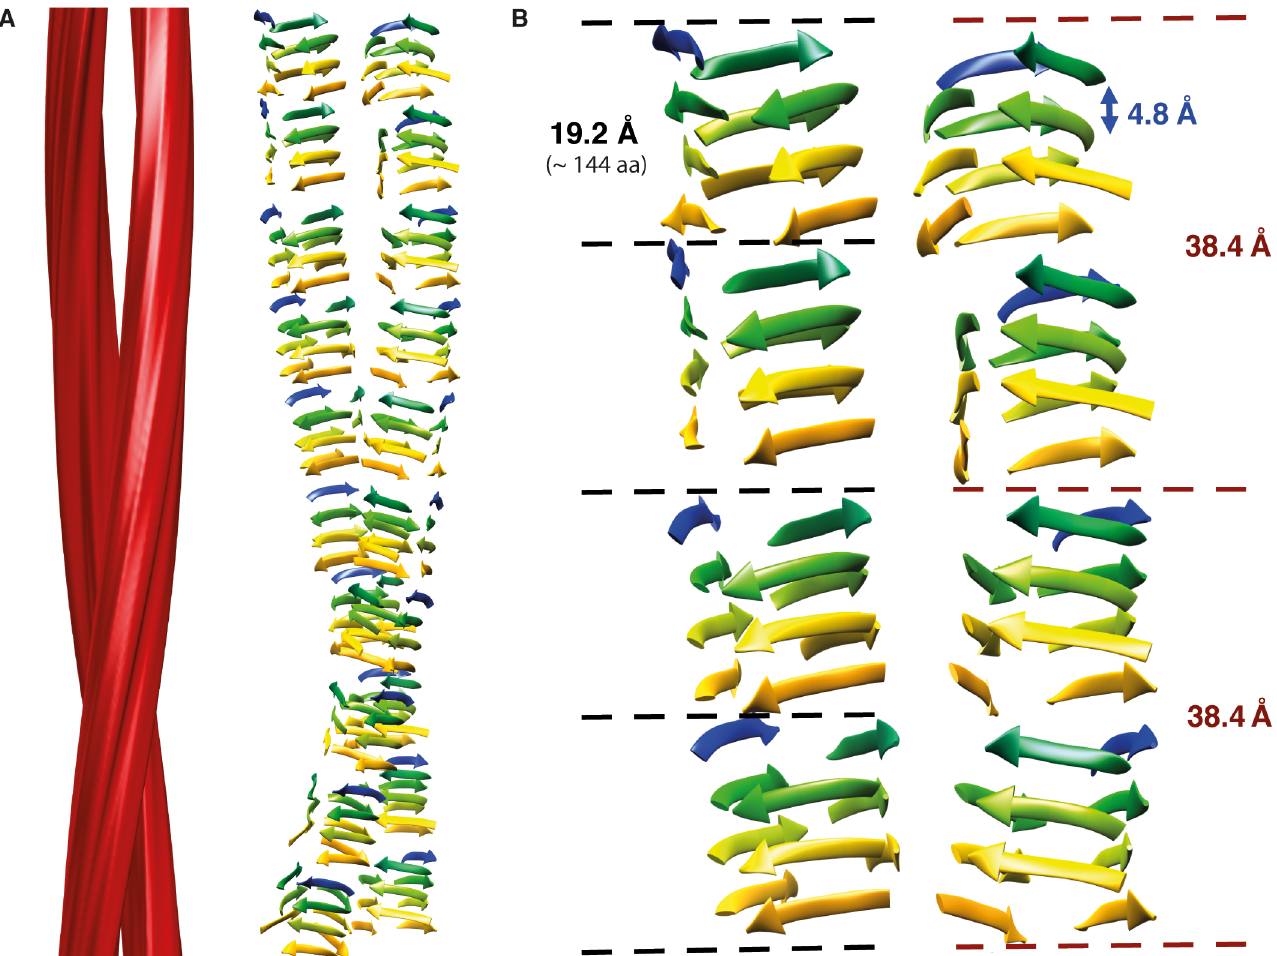
Fig 8. A GPI-anchorless PrP 27 – 30 fibril and its structural outline. ( A ) 3D reconstruction of an individual GPI-anchorless PrP 27 – 30 fibril with two protofilaments (left). Cartoon depicting the potential configuration of the polypeptide chains in the PrP 27 – 30 monomers (right). Please note that this is NOT an atomistic model for the structure of PrP Sc . ( B ) Close up view of the possible ß-sheet stacking in a four-rung ß-solenoid structure for illustration purposes only. Different colors represent different ß-solenoid rungs. Characteristic distances of the four-rung ß-solenoid architecture are labeled. One critical constraint for the threading of the PrP sequence into a four-rung solenoid is accommodating the disulfide bridge between cysteines 179 and 214, which is known to be preserved in PrP Sc . As in a model of the insulin amyloid, also proposed to be solenoid-like, the two cysteines might be located in register, in corners of two consecutive rungs, with the disulfide bond parallel to the protofilament axis [31,34].